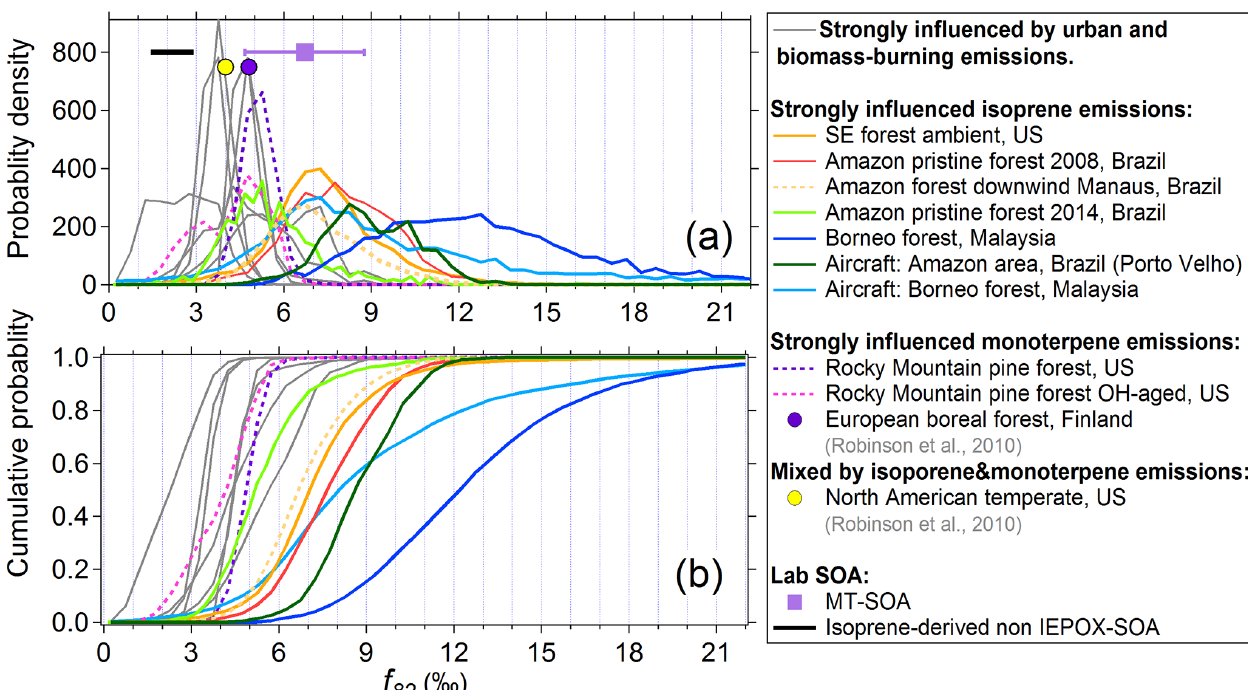
Figure A2. (a) Probability density and (b) cumulative probability distributions of f 82 in studies strongly influenced by isoprene and/or monoterpene emissions. The ranges of f 82 from other non-IEPOX-derived isoprene-SOA and MT-SOA are also shown. The background grey lines are from studies strongly influenced by urban and biomass-burning emissions and are the same data from Fig.